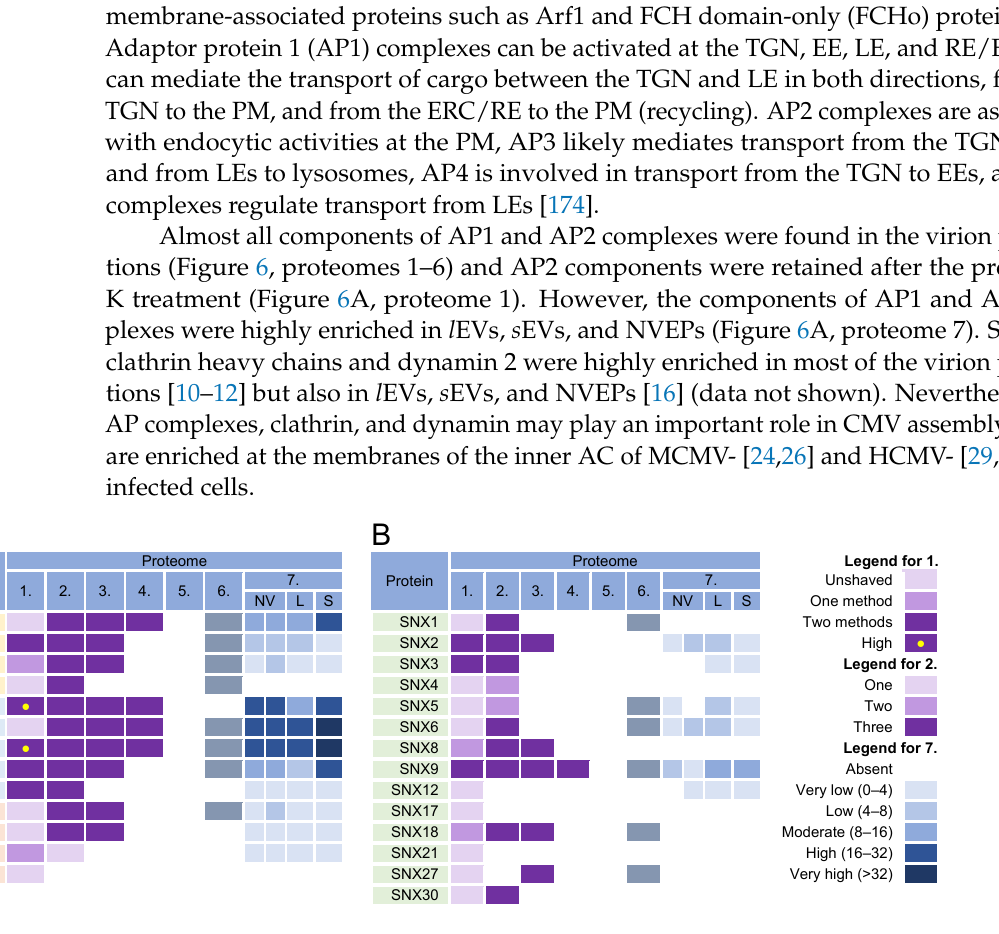
Figure 6. Identification of ( A ) adaptor protein (AP) complexes and ( B ) sorting nexins (SNX) in virions and NVEPs in extracellular vesicle preparations. The proteins are identified in five proteomes of HCMV virion preparations (proteome 1–5), proteomes of HSV-1 heavy particles (proteome 6), and NVEPs (proteome 7), as described in Figure